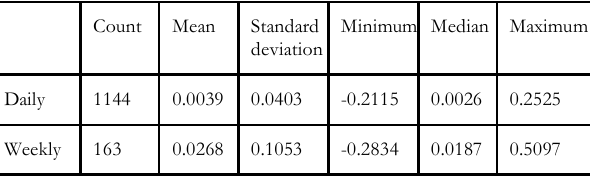
Table 2: Statistics summary for price returns of Bitcoin